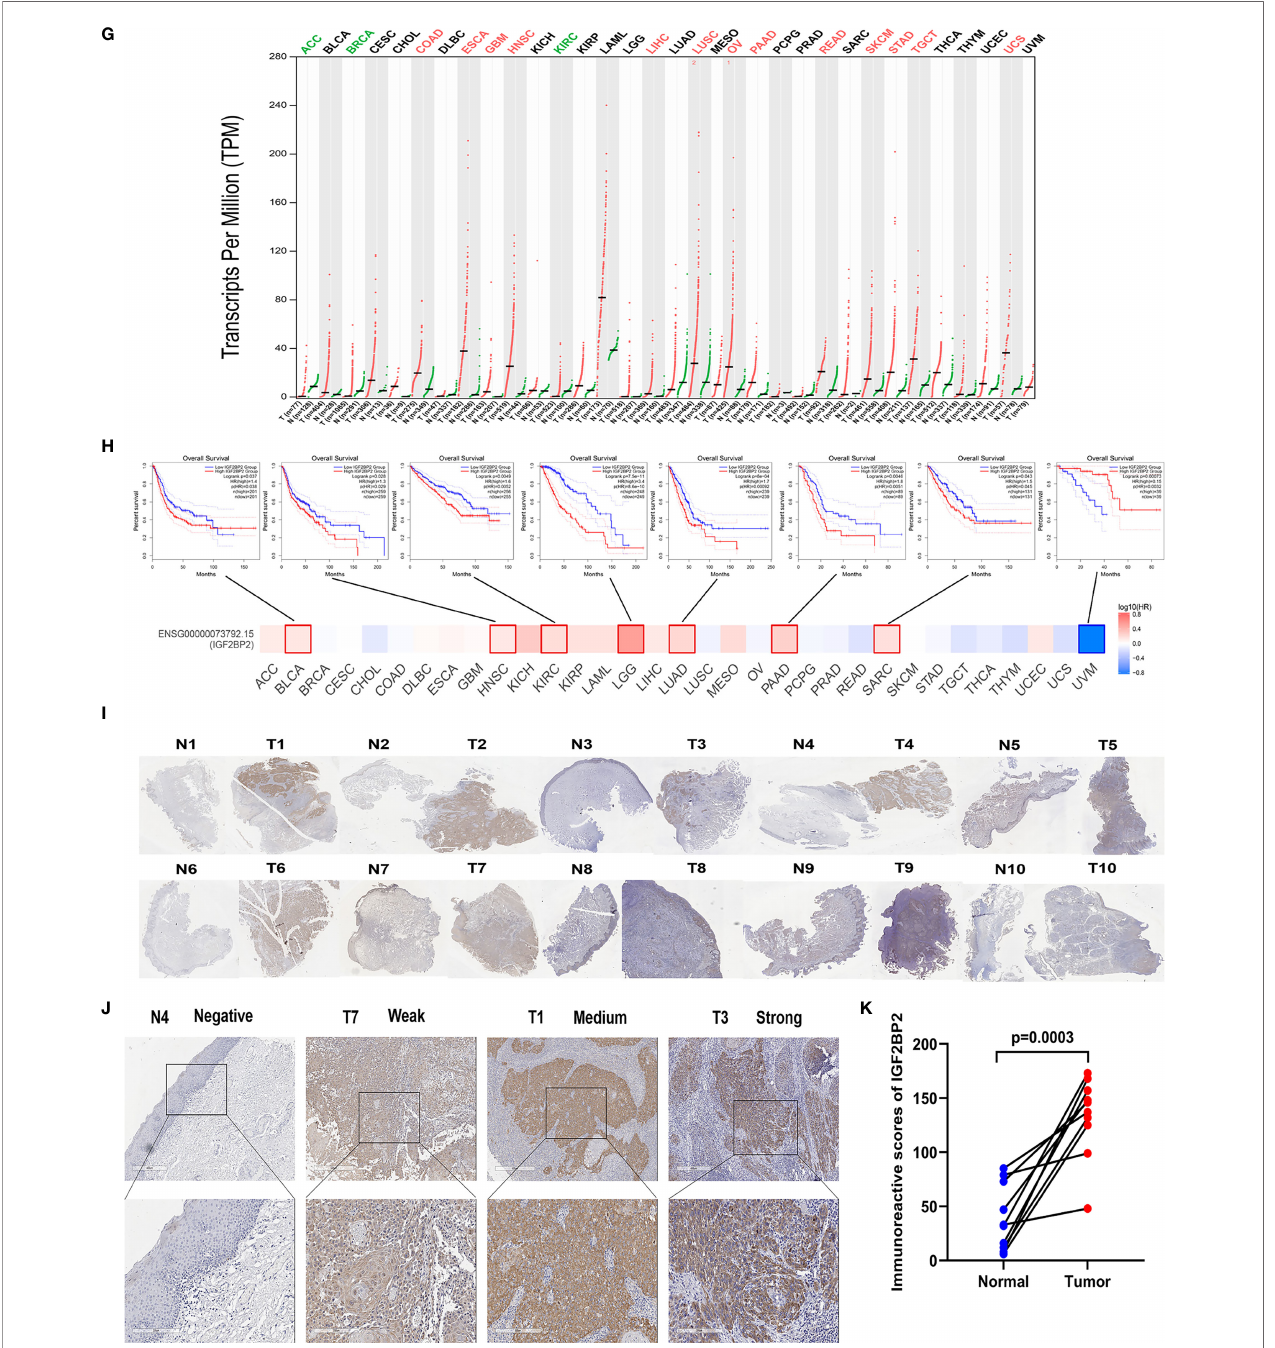
FIGURE 3 | IGF2BP2 was selected as a hub gene through prognostic analysis. (A) Volcano plot of 2,393 DEGs between normal (N=30) and OSCC (N=306) tissues from the TCGA database. (B) Volcano plot of 2,217 DEGs between OSCC and normal tissues from the GSE30784 dataset. (C) The Venn diagram shows 12 common genes of DEGs and hub genes from WGCNA between OSCC tissues and normal tissues in the TCGA and GSE30784 datasets. (D, E) The forest plots show the hazard ratios and 95% con fi dence intervals of 12 hub genes associated with OS in TCGA-OSCC (D) and GSE42743 datasets (E) according to univariate Cox regression analysis. (F) Kaplan – Meier curves of OS based on HNSC patients in the TCGA database with high and low ANO1 and IGF2BP2 expression. (G) Differential expression of IGF2BP2 in 33 different tumor tissues and paired normal tissues from the TCGA and GTEx databases. Each dot represents the expression of samples. (H) The prognostic impact of IGF2BP2 expression level based on the survival heatmap, showing signi fi cance in BLCA, HNSC, KIRC, LGG, LUAD, PAAD, SARC, and UVM. (I) Images of IHC staining for IGF2BP2 in 10 pairs of OSCC tissues (T) and adjacent noncancerous normal tissues (N). Magni fi cation at 50× (J) Representative images of IHC staining for IGF2BP2 in adjacent noncancerous normal tissues and OSCC tissues. Magni fi cation at 200× (K) Histological scoring of IGF2BP2 in 10 pairs of OSCC tissues and adjacent noncancerous normal